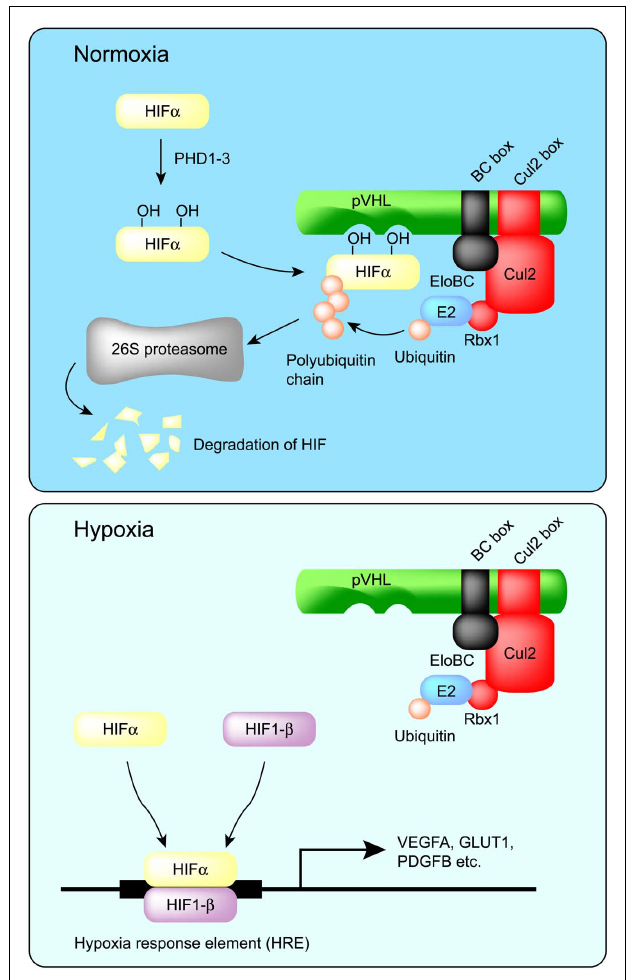
FIGURE 2 | Regulation of HIF- α protein by pVHL. In normoxia, two proline residues of HIF- α are hydroxylated by PHD1–3, and then HIF- α is recognized by pVHL for polyubiquitination and degradation by the proteasome. On the other hand, in hypoxia, HIF- α escapes prolyl hydroxylation and thereby escapes degradation. HIF- α then dimerizes with HIF-1 β to form an active transcription complex. Prolonged activation of the HIF α / β transcription complex is a major contributor toVHL